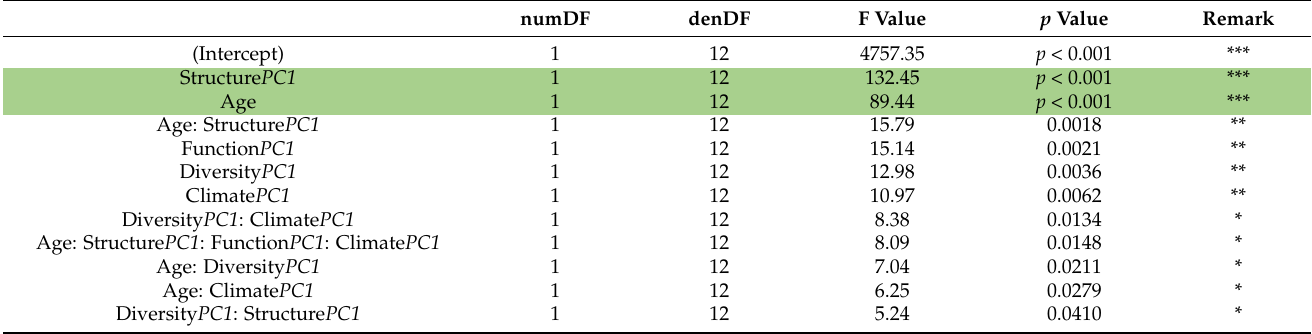
Table 2. Summary of the linear mixed-effect model of the effects of age, diversity PC1 , structure PC1 , function PC1, and climate PC1 on aboveground wood carbon, which were analyzed for coniferous mixed forests (CMF). PC1 refers to the first principal component of the results of principal component analysis. The colons represent interactions between the components. Only significant components ( p < 0.05) are reported, and the green areas are the highly significant influence components. numDF denDF F Value p Value